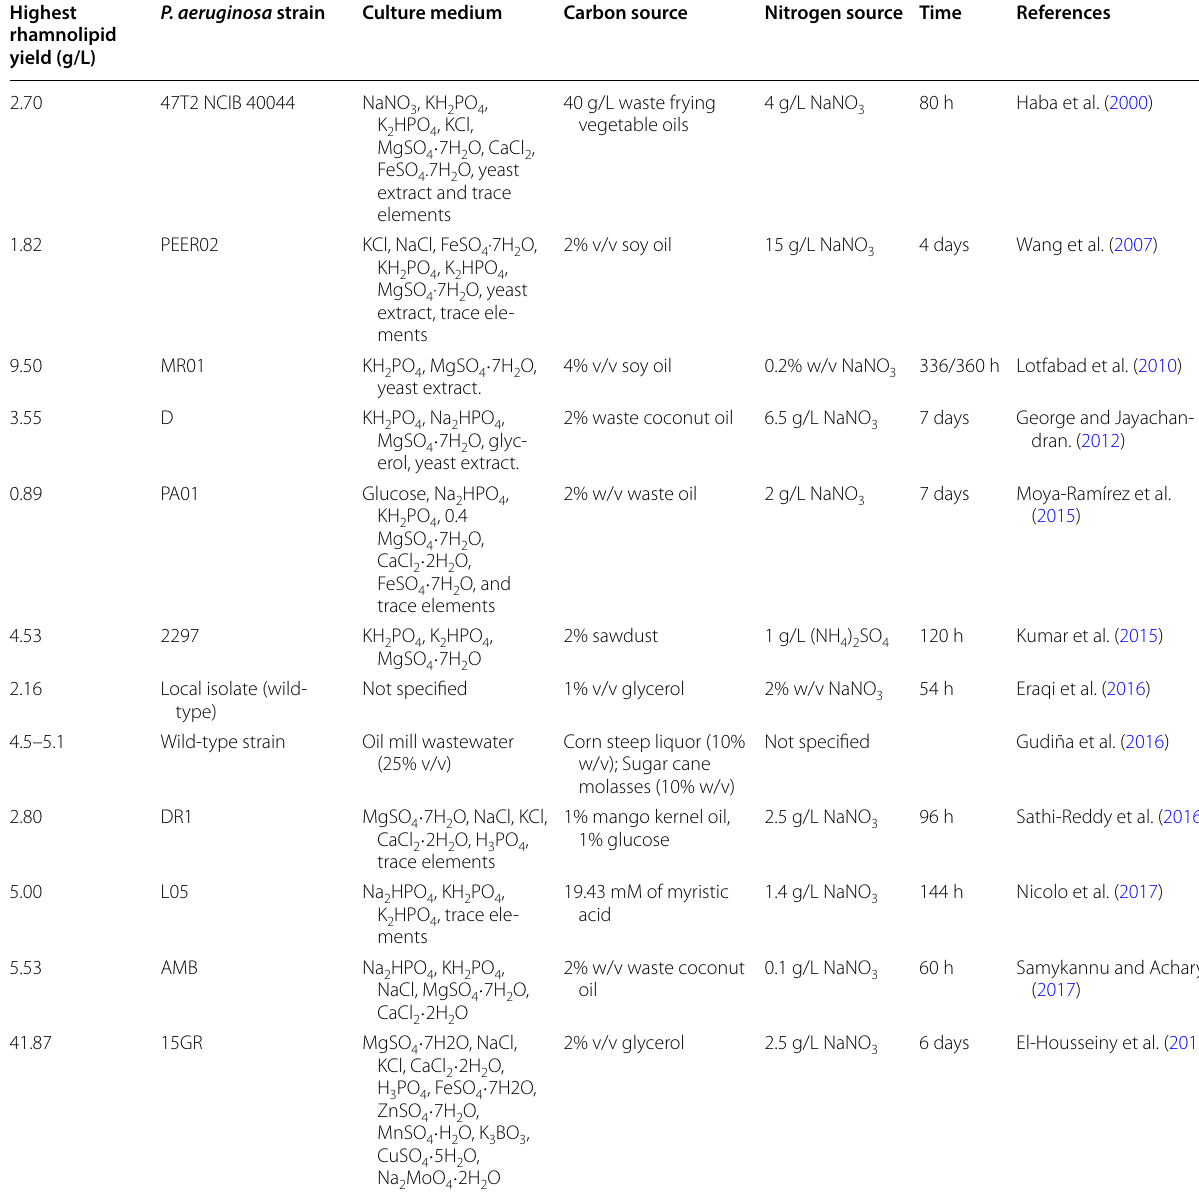
The highest rhamnolipid yield and the used P. aeruginosa strain in each case is reported